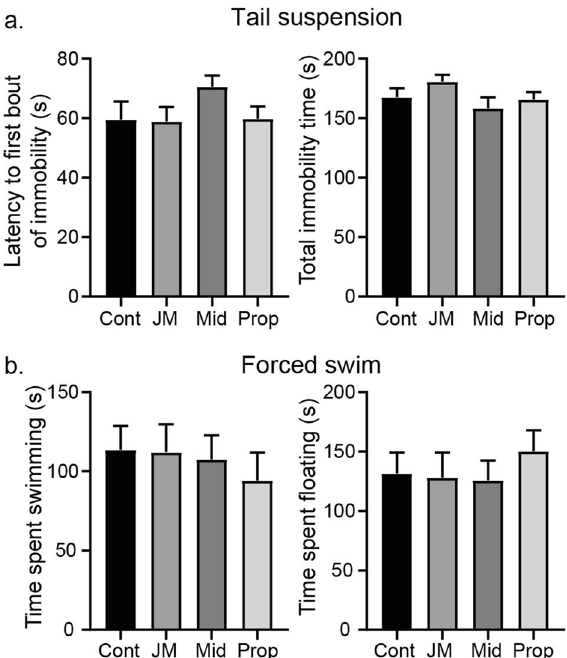
Figure 6. Neonatal administration of JM-1232(−) does not induce depression-like symptoms in adulthood. Comparison and quantitation of performance on ‘depression’ tests in adulthood after administration of JM-1232(−), midazolam, and propofol in P6 mice. ( a ) Mean latencies to immobility (left) and mean total immobile time (right) in tail suspension test. All anaesthetic groups were statistically indistinguishable on